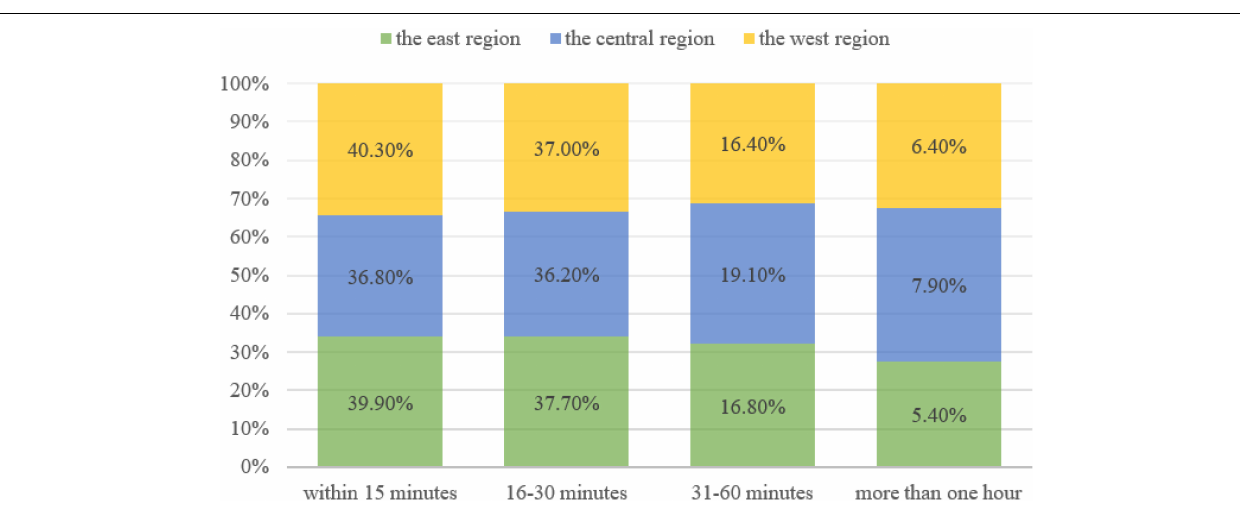
FIGURE 4 | The public cultural participation environment in east, central and west regions in